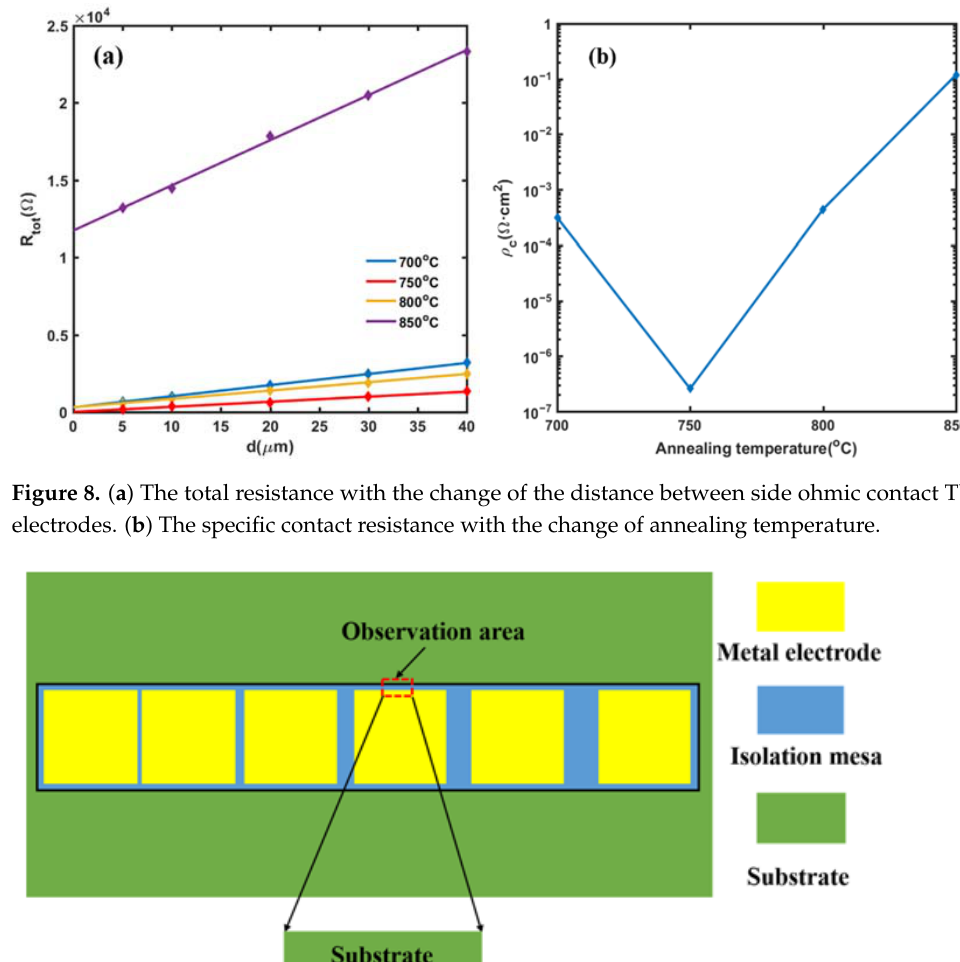
Figure 7. ( a ) I ‐ V characteristics of side ohmic contact TLM electrodes, with a distance of 40 μ m at different annealing temperatures. ( b ) The total resistance of side ohmic contact TLM electrodes with the change of annealing temperature.